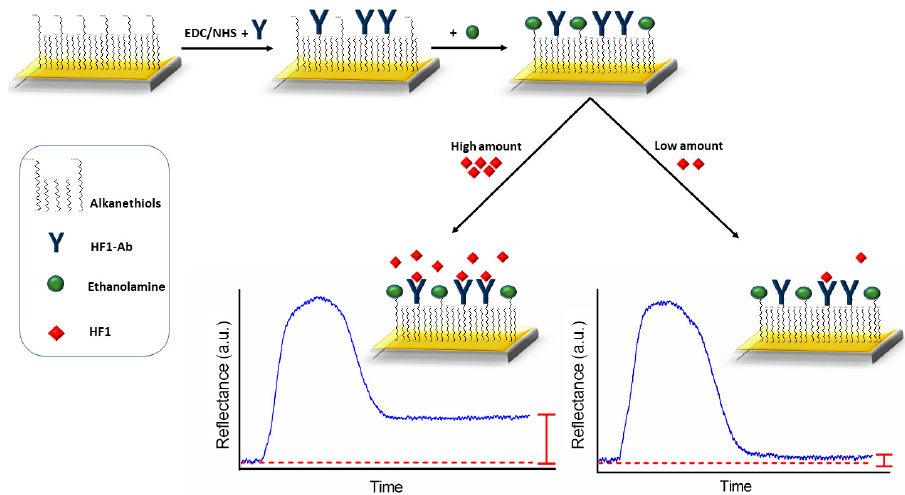
Figure 2. Schematic of the SPR immunoassay for detecting HF1 and illustrative representation of sensograms.